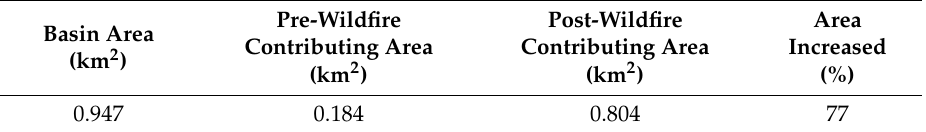
Figure 20. Pre- and post-wildfire contributing area for the debris flow event on 16 August. The blue line indicates the watershed of basin 11. For the basin’s location see Figures 8 and 19b. Table 4. Dimensions of the debris flow contributing